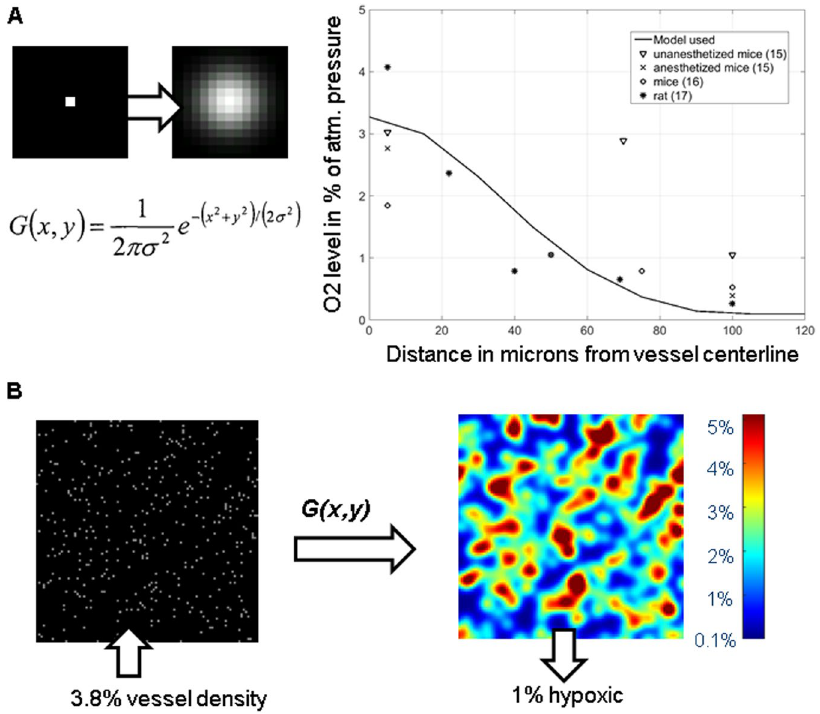
Figure 2. Modeling steady state oxygen concentrations in tumour. ( A ) The diffusion process is modeled as a Gaussian filter applied on the vessel map. The coefficient of diffusion of the filter was calibrated on experimental data of the partial pressure of O2 in mmHg against the distance from one vessel wall on colon and mesentery. ( B ) D (diffusion coefficient of O2 from the vessel) was fixed in a plausible range to fit experimental data to a vessel density at 3.8% and checking D values for which the percentage of hypoxia area (threshold at 0.2% in the O2 map) was measured experimentally below 1% 55 , while conserving an average level of O2 in the tumour of about